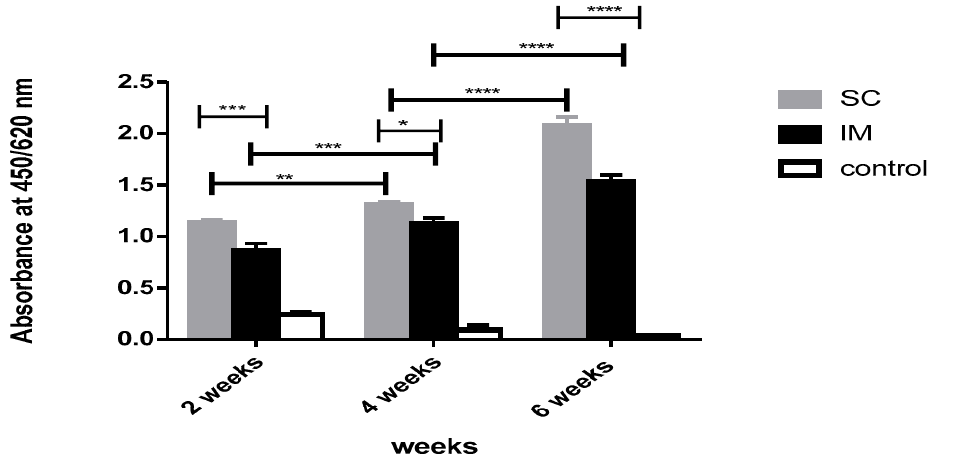
Figure 5. Immune response of SC route versus IM route after immunization with NmC-BG. A bar chart showing antibody response in rats measured in terms of absorbance values in weeks 2, 4, and 6 after immunization with BG vaccine against PBS (control) through subcutaneous (SC) and intramuscular (IM) immunization routes. Error bars represent the standard deviation from the mean. * Indicates significance with p < 0.05, ** indicates significance with p < 0.01, *** indicates significance with p < 0.001, and **** indicates significance with p < 0.0001.